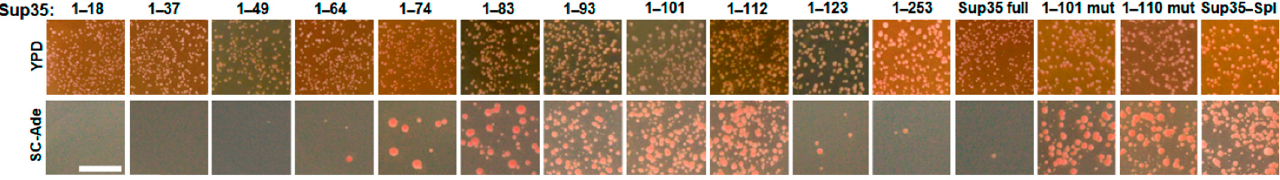
Figure 2. Frequency of the [ PSI + ] appearance caused by the tested Sup35N proteins. Yeast were plated as single cells to YPD medium or Sc-Ade, Adenine omission medium selective for [ PSI + ] cells. 30-fold more cells were plated to Sc-Ade medium. The scale bar is 1 cm. Sup35 variants are indicated on top.